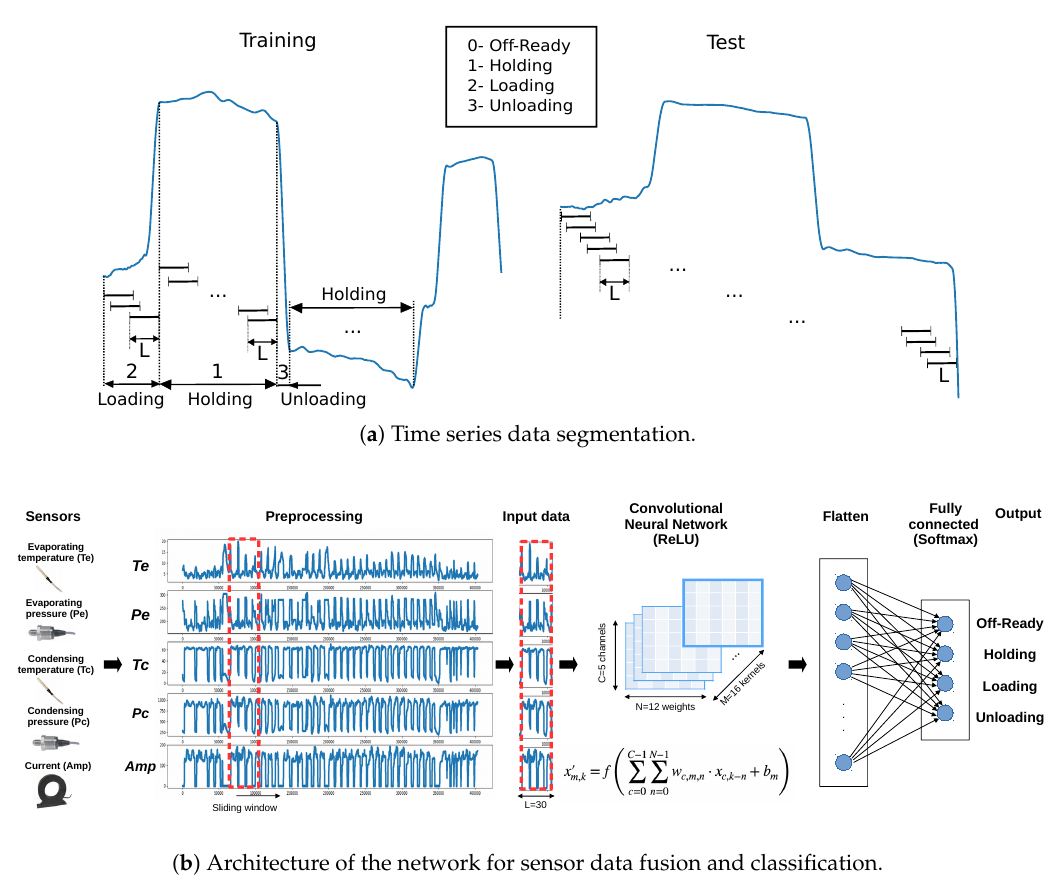
Figure 5. Data-level and algorithmic phases of the proposed